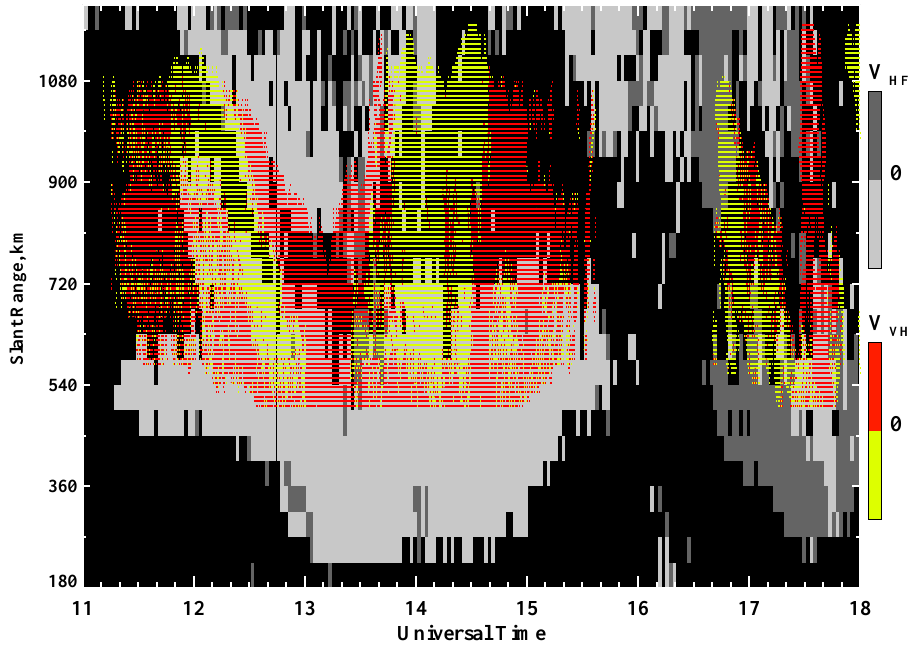
Fig. 8. Comparison between the CUTLASS (beam 9) and STARE (beam 8)